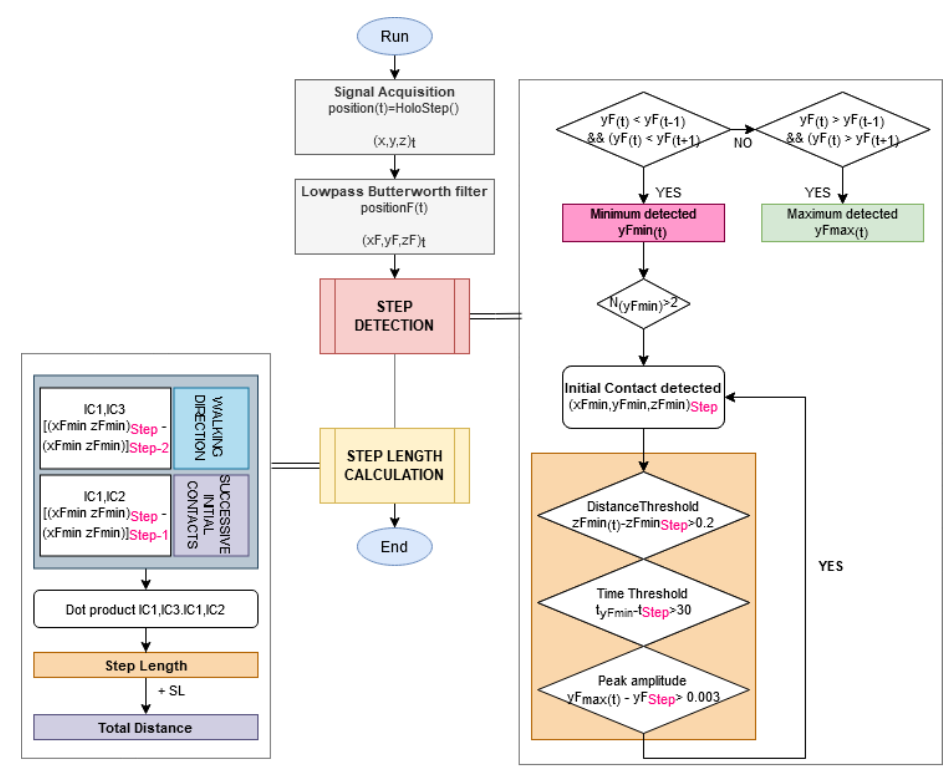
Figure 5. Flow chart of the proposed method HoloStep for step detection and step length calculation of children with